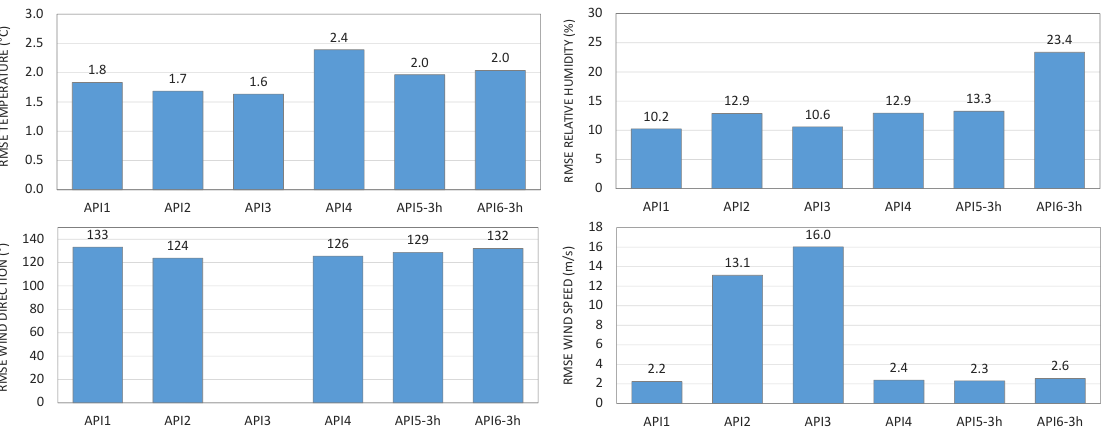
Figure 3. Root Mean Square Error ( RMSE ) for 1 day-ahead prediction horizon between observation and forecasts from different weather providers (from 6 February 2018 to 6 May 2018). Above left : RMSE temperature; above right : RMSE relative humidity; below left : RMSE wind direction; below right : RMSE wind